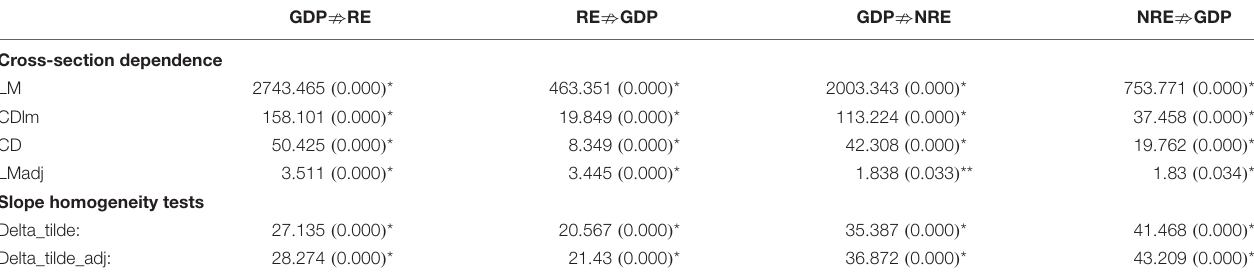
TABLE 2 | Results of cross-sectional dependence and homogeneity tests.